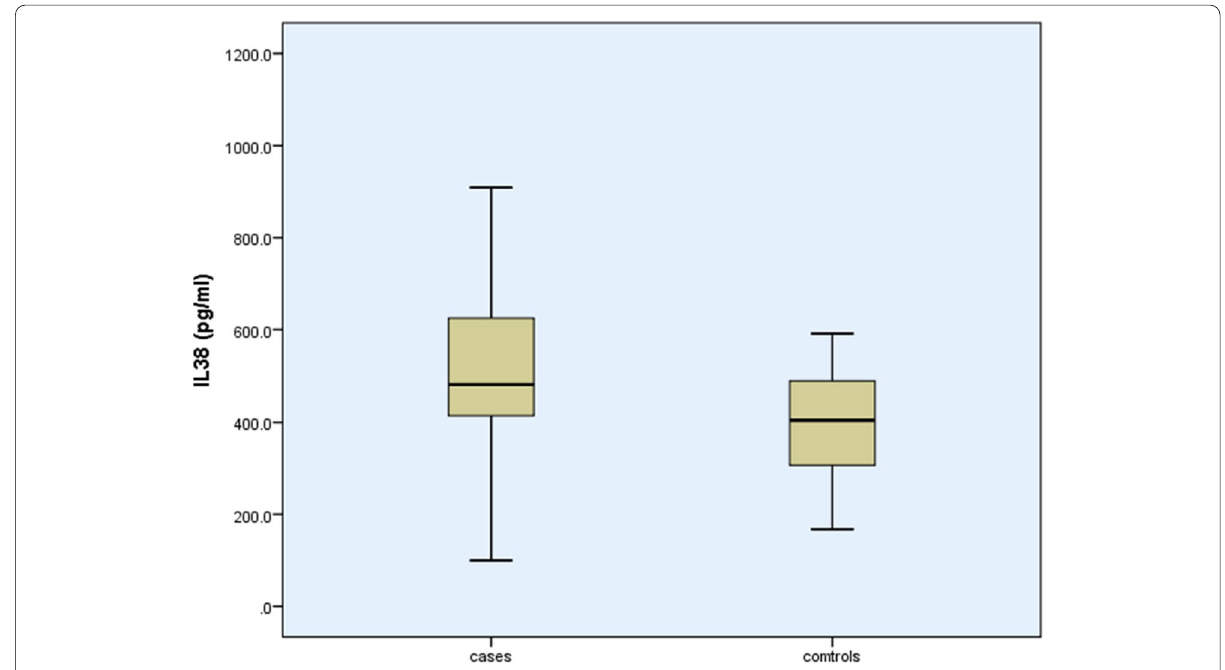
Fig. 1 IL-38 serum levels in asthmatic patients and healthy control